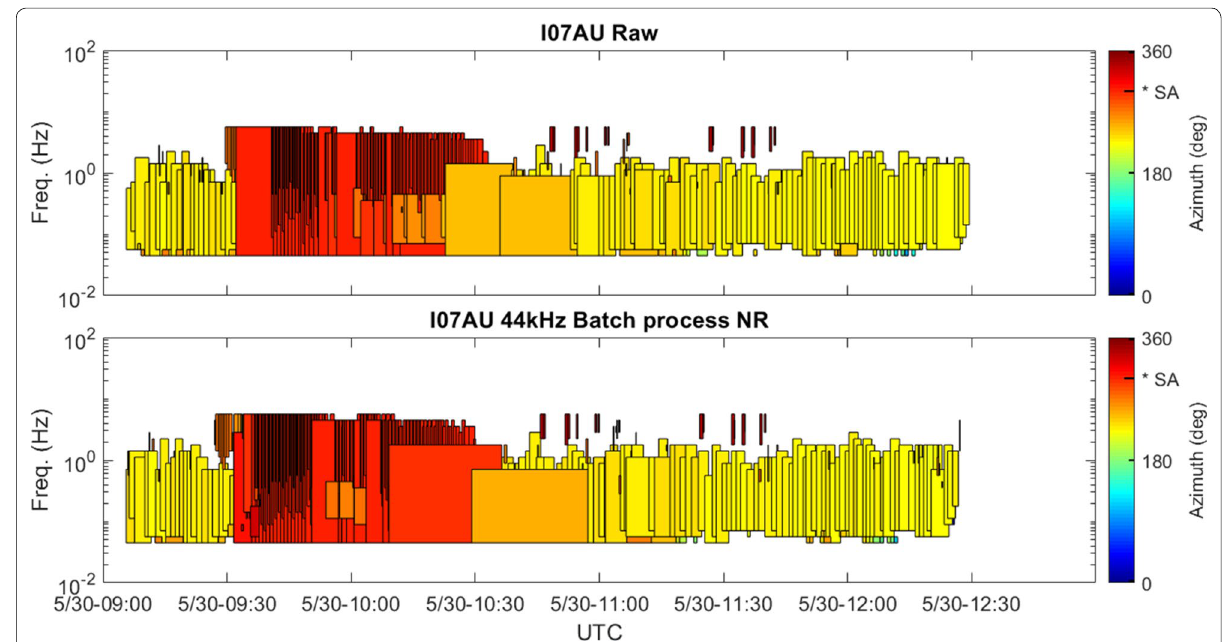
Fig. 8 Array processing results for I07AU (top) and pre-processed array processing results (bottom). This figure illustrates that even with a clear detection the pre-processing does not erode the detectability of the